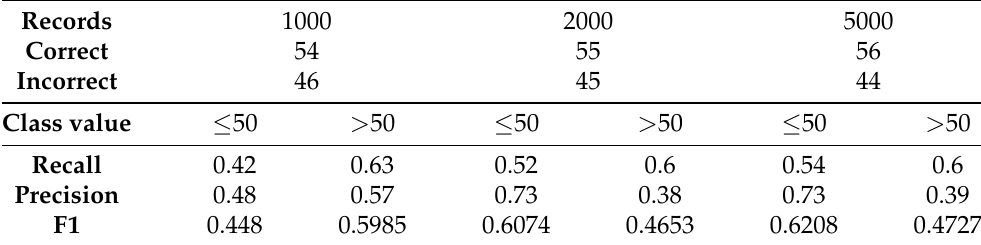
Table 5. TAN classifier evaluation